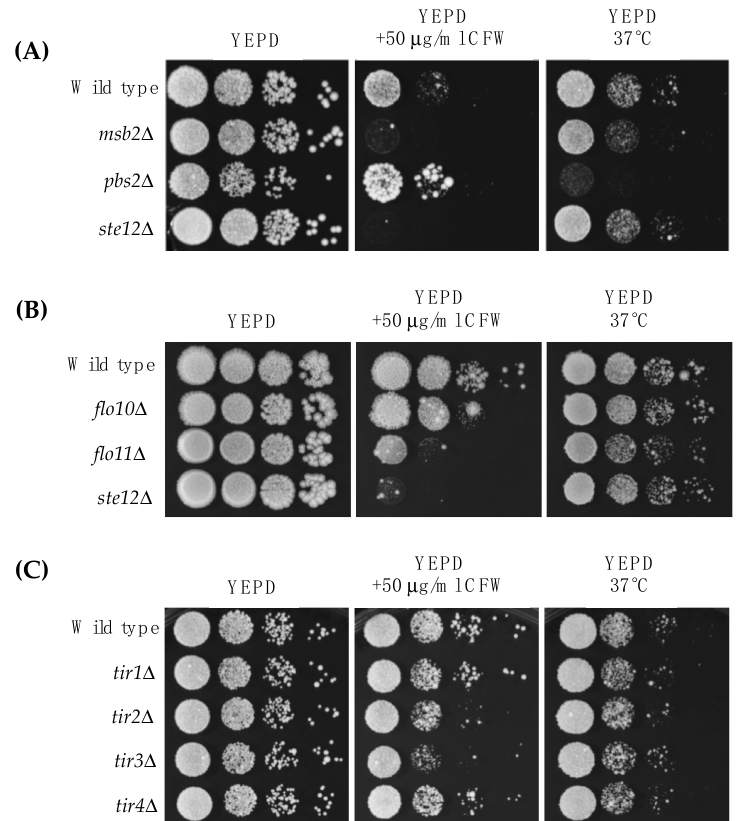
Figure 2. Role of MAPK pathways in regulating cell wall stress in yeast. ( A – C ) 0.1 O.D 600 of wild type (PC538) and indicated strains (see Table 1 for strain numbers) were spotted in 10-fold serial dilutions onto YEPD media supplemented with or without CFW at a final concentration of 50 µg/mL. Plates were incubated at 30 °C or 37 °C and photographed after two days of growth (panels A and C) or three days (panel B).